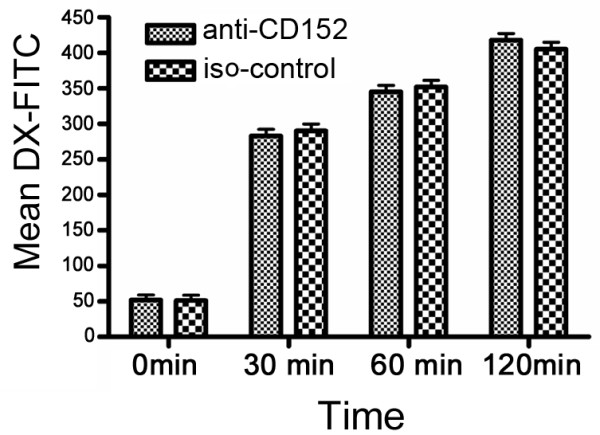
The culture of immature DCs in wells coated with anti-CTLA4 antibody did not affect their endocytic activity. Endocytosis was evaluated as the uptake of FITC-DX at the indicated times, which was measured by FACS. The data for one experiment are shown, and are representative of three independent experiments.